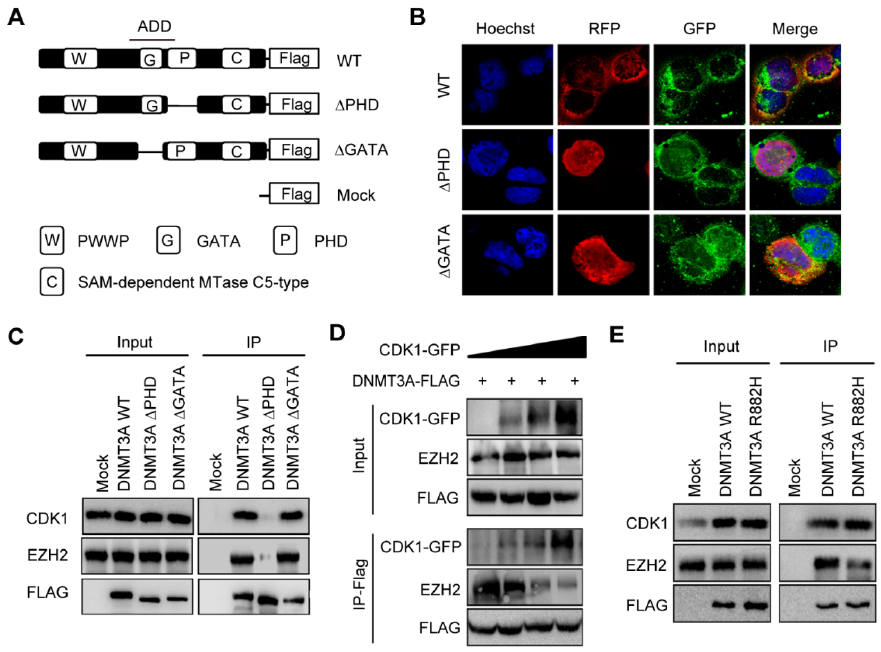
Figure 2. CDK1 overexpression interrupted the binding of EZH2 to PHD domain of DNMT3A. ( A ) Truncated DNMT3A- ∆ PHD and ∆ GATA were constructed by editing ADD domain as indicated. ( B ) Immunofluorescent localization of CDK1, WT DNMT3A, ∆ GATA, and ∆ PHD proteins in 293T cells. ( C ) Co-immunoprecipitation of CDK1, EZH2, and DNMT3A proteins in 293T cells expressing truncated DNMT3A or WT DNMT3A. ( D ) Co-immunoprecipitation of CDK1, EZH2, and wild-type DNMT3A proteins in 293T cells transfected with FLAG-tagged DNMT3A(DNMT3A-FLAG) and GFP-tagged CDK1 (CDK1-GFP) as indicated. ( E ) Co-immunoprecipitation of CDK1, EZH2, and DNMT3A proteins in 293T cells ex- pressing DNMT3A R882H or WT DNMT3A.